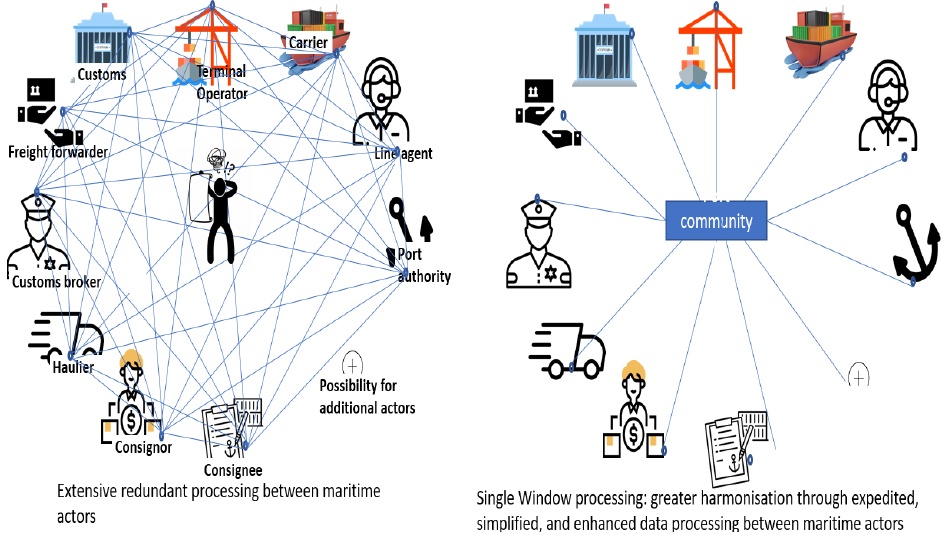
Figure 1. An exemplary representation of port community members before and after PCS: a single- window solution elaborated by the